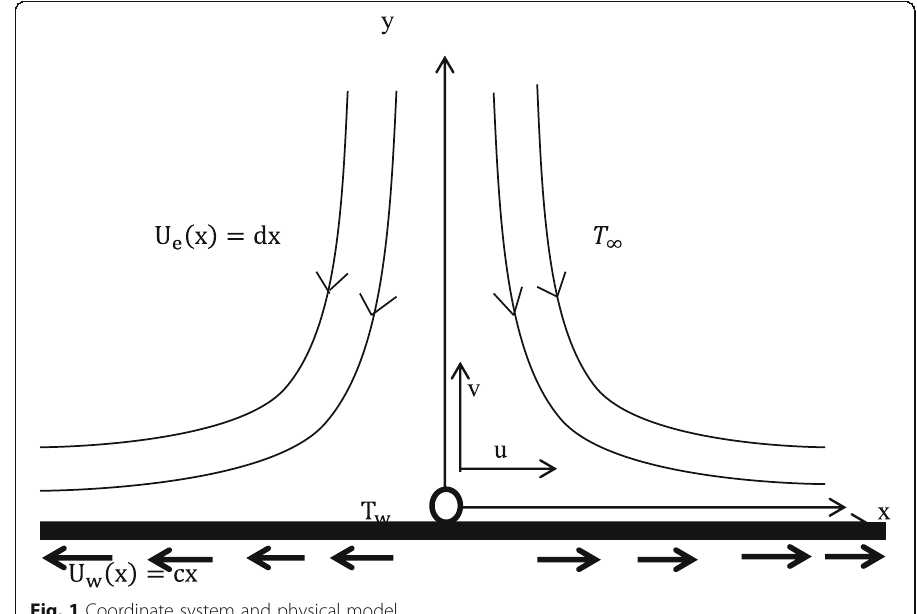
Fig. 1 Coordinate system and physical